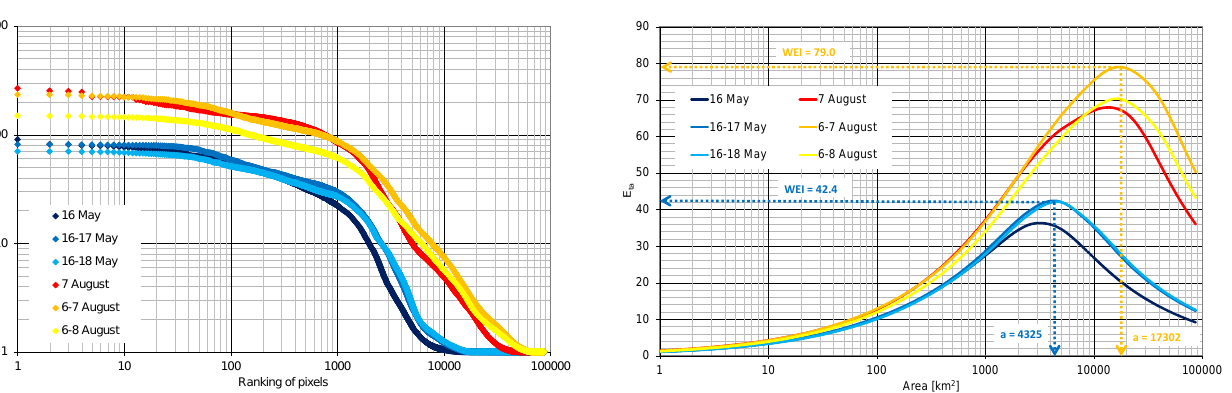
Fig. 4. The distribution of return periods of precipitation totals in individual grid pixels during reference events.